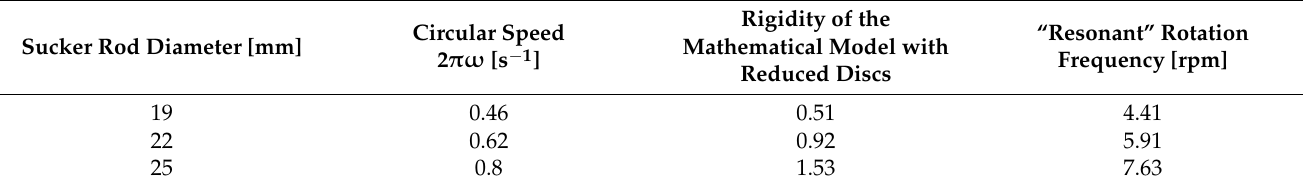
Table 5. Estimated data for well no. 3633 operated by Ideloil